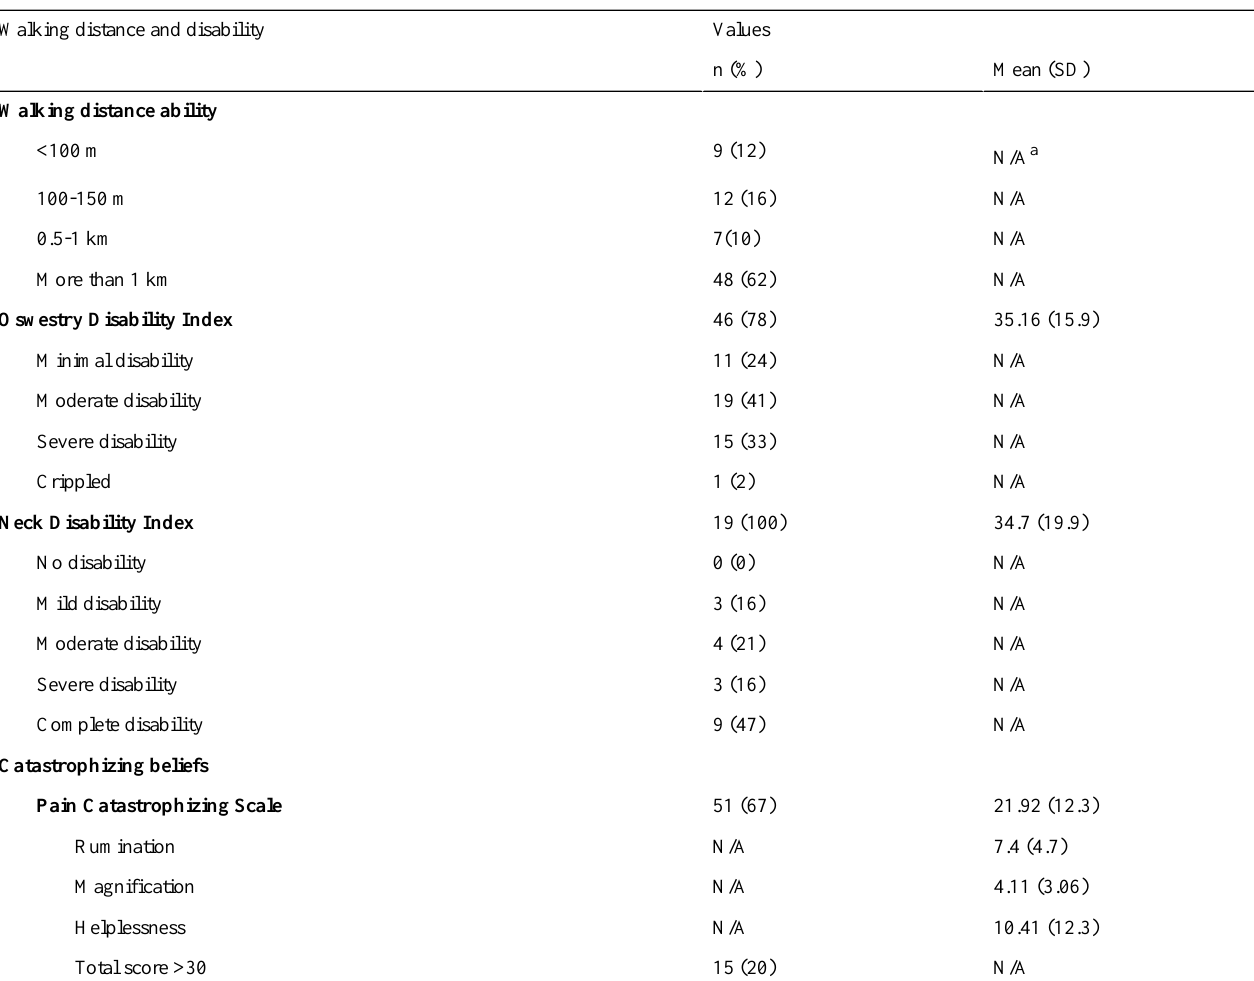
Table 2. Baseline walking distance ability, disability, and catastrophizing scores. ValuesWalking distance and